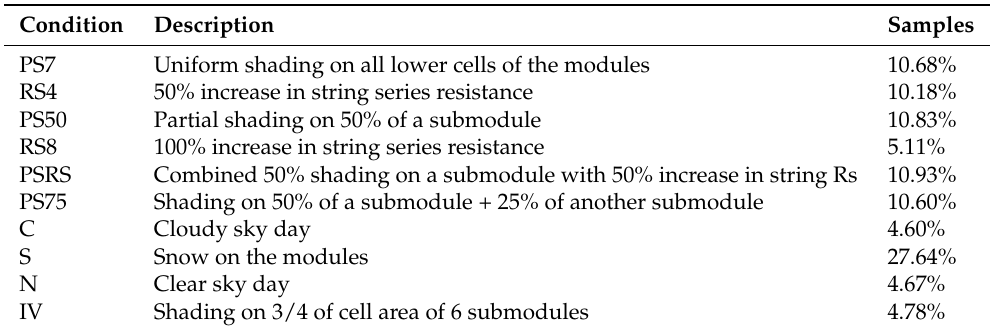
Table 1. An overview of the PV system dataset used for this research. The dataset comprises 10 categories from approximately 15,000 data samples of a varied